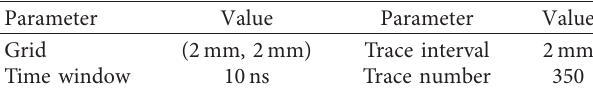
Figure 6: Void defect model without rebar. Table 1: Parameters of the forward simulation.